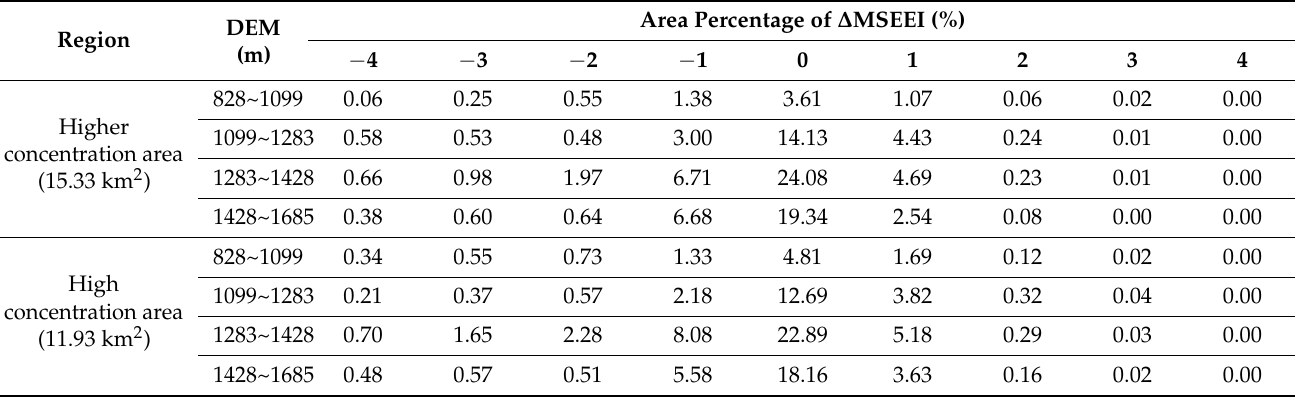
Table 5. MSEEI in each grade percentage of